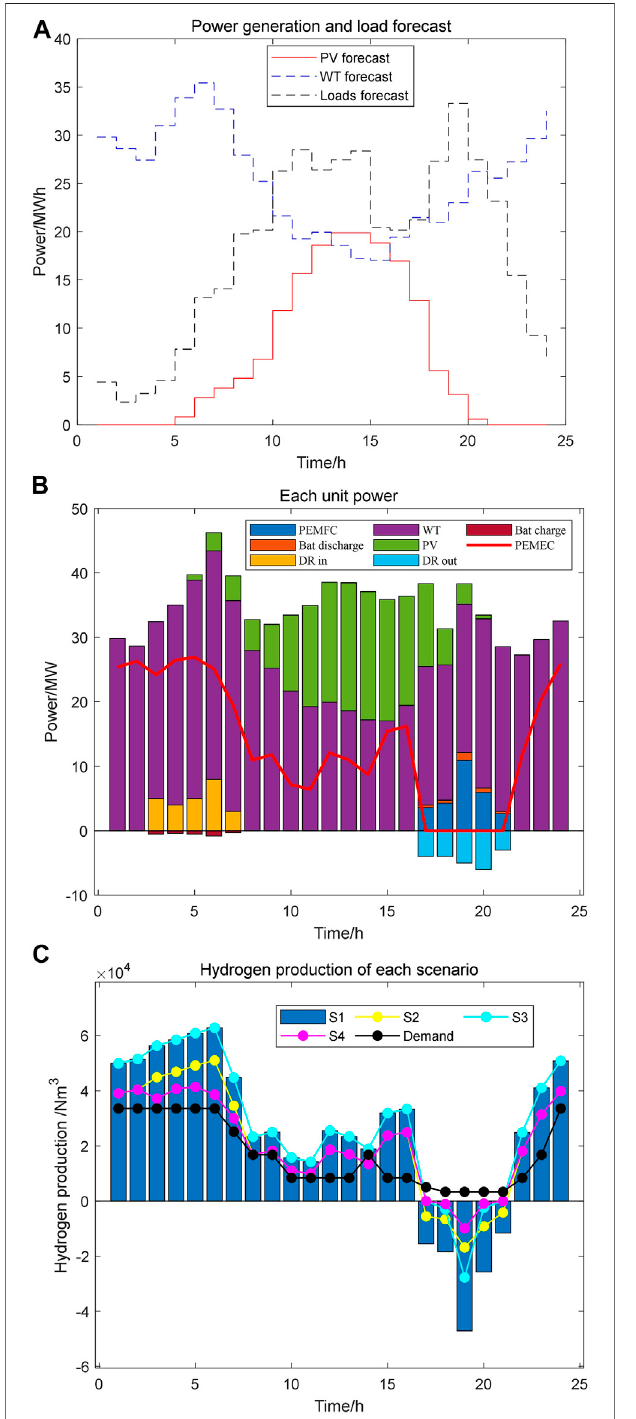
FIGURE 9 | (A) Day-ahead forecast results of a typical winter day, (B) each unit power of a typical winter day, (C) hydrogen production and hydrogen demand of a typical winter